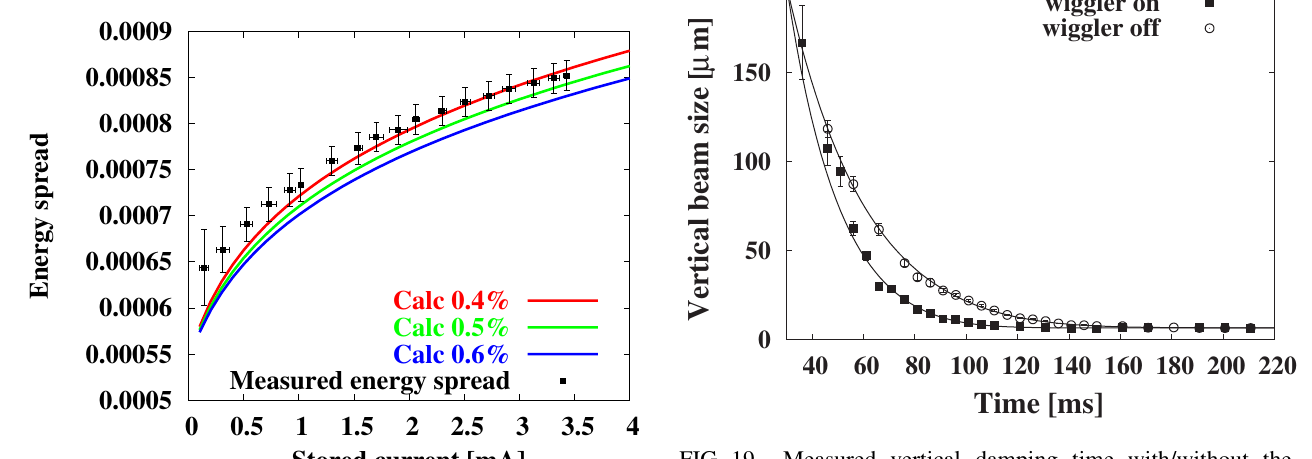
FIG. 19. Measured vertical damping time with/without the damping wigglers. The horizontal axis shows the elapsed time from beam injection into the damping ring. The vertical axis shows the measured beam size by the FZP monitor. The open circles (black boxes) show the vertical beam sizes without (with) damping wigglers.